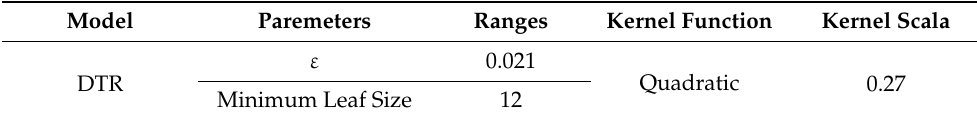
Table 9. Parameters for DTR